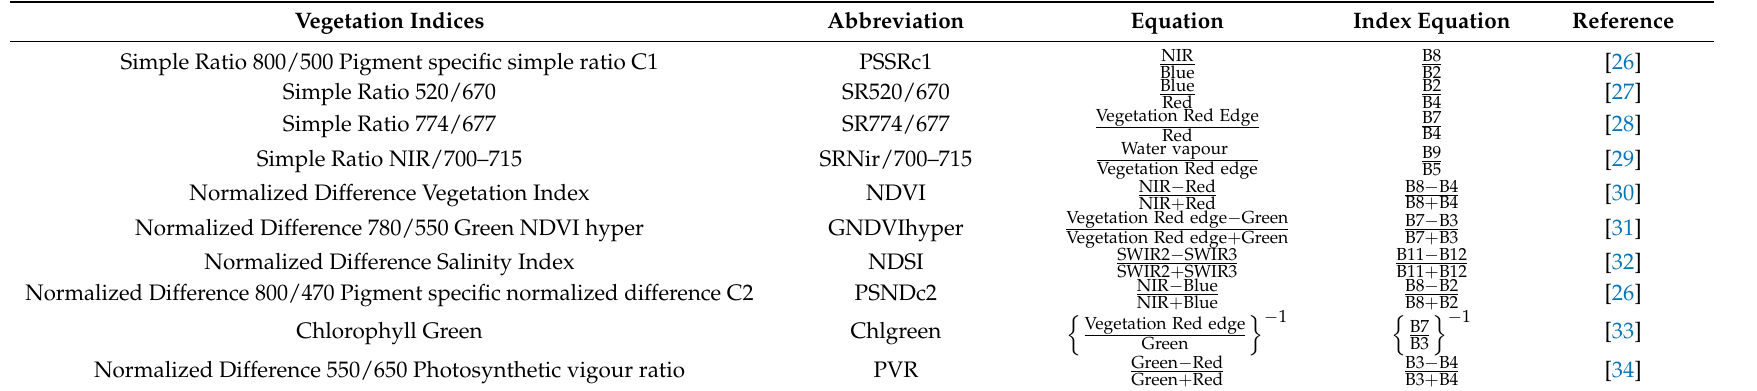
Table 2. Sentinel 2 vegetation indices tested in this